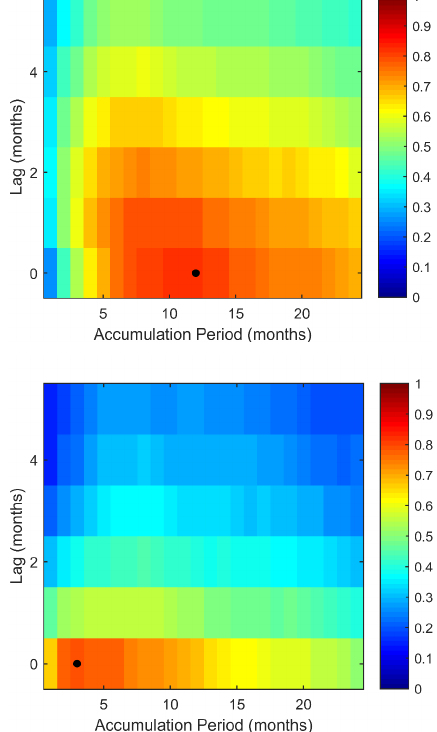
Figure 4. (a) Heatmap of the correlation between lagged English Lowlands river flow SSI over a 1 month timescale and English Low- lands precipitation as SPI over 1–24 months, with maximum corre- lation highlighted with the black circle. (b) Heatmap of the correla- tion between lagged English Lowlands groundwater level SGI over a 1 month timescale and English Lowlands precipitation as SPI over 1–24 months, with maximum correlation highlighted with the black